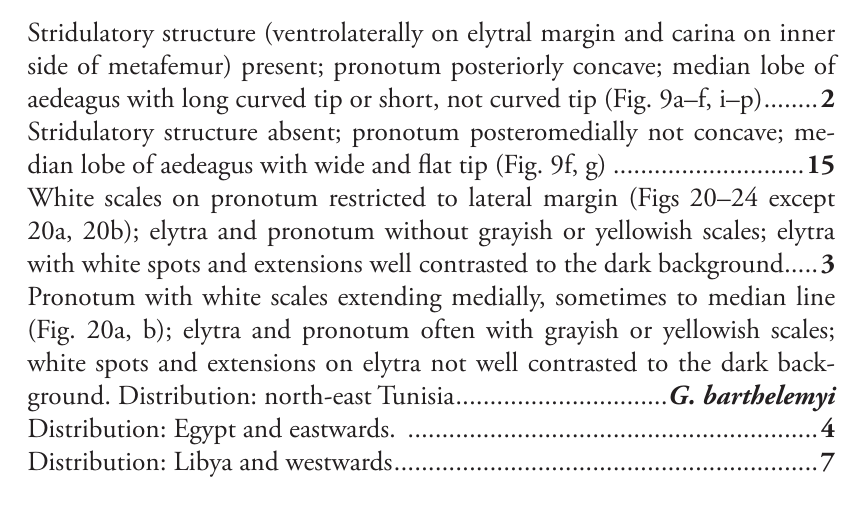
Figure 28. Dorsal habitus of Graphipterus : a G. valdanii b G. serrator holotype (ZMUC) c G. serrator holotypes’ label d Graphipterus variegatus holotype (ZMUC).